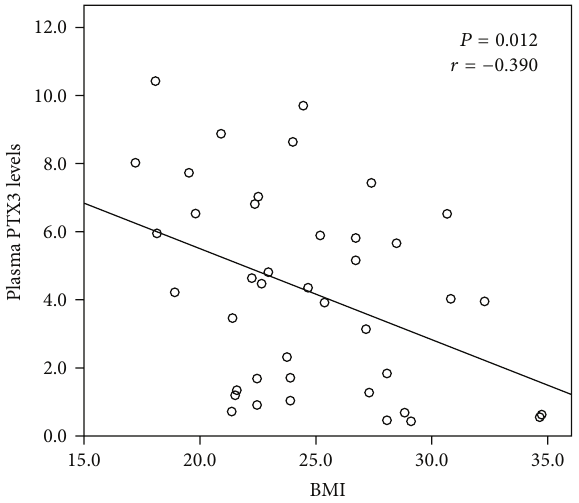
Figure 2: Univariate correlation between plasma PTX3 levels and BMI in Malay men with normal glucose tolerance.